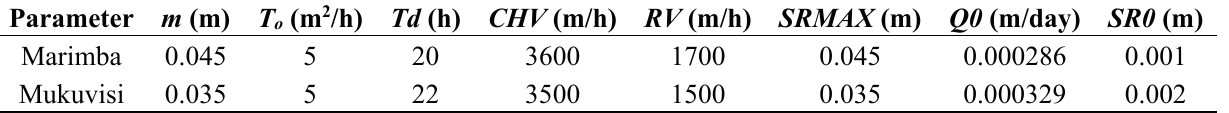
13. Optimized parameter values used in the model for Marimba and Mukuvisi catchments. Parameter